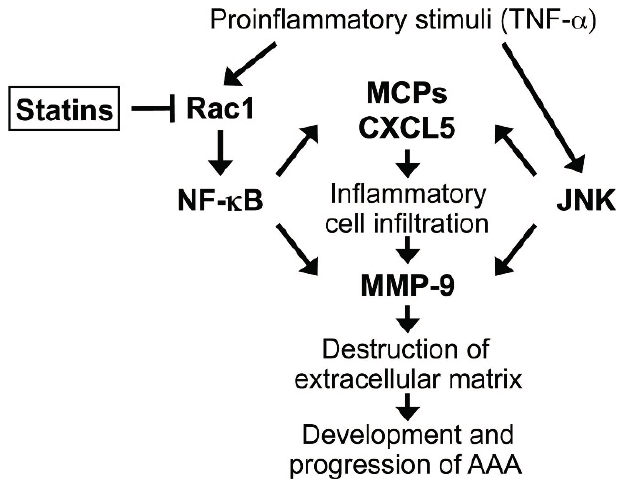
Figure 7. Scheme of how inhibiting the Rac1/nuclear factor (NF)- κ B pathway with statins could limit abdominal aortic aneurysm (AAA) growth. Activation of both NF- κ B and c-jun N -terminal kinase (JNK) signals results in inflammatory cell infiltration by upregulating chemokine secretion and in aortic wall destruction by activating matrix-degrading proteases. Statins preferentially inhibit the Rac1/NF- κ B pathway, potentially leading to reduced progression of